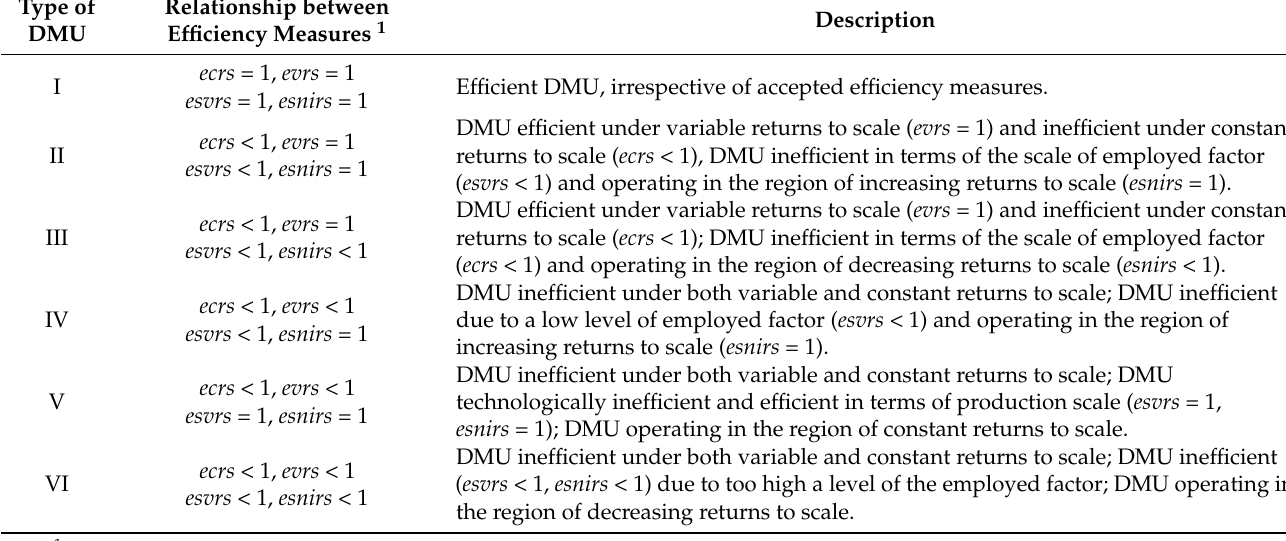
Table 1. Economy of the scale of objects achieved on the basis of the relationship between the efficiency measures and the